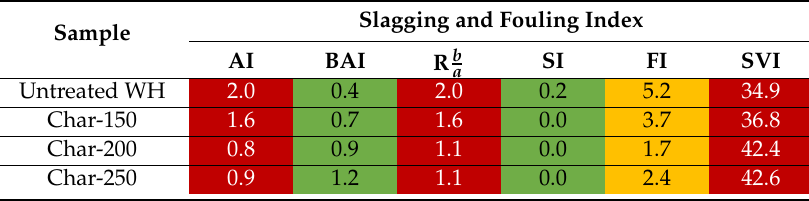
Table 4. Slagging and fouling indices for untreated water hyacinth (WH) and hydrochars. Sample